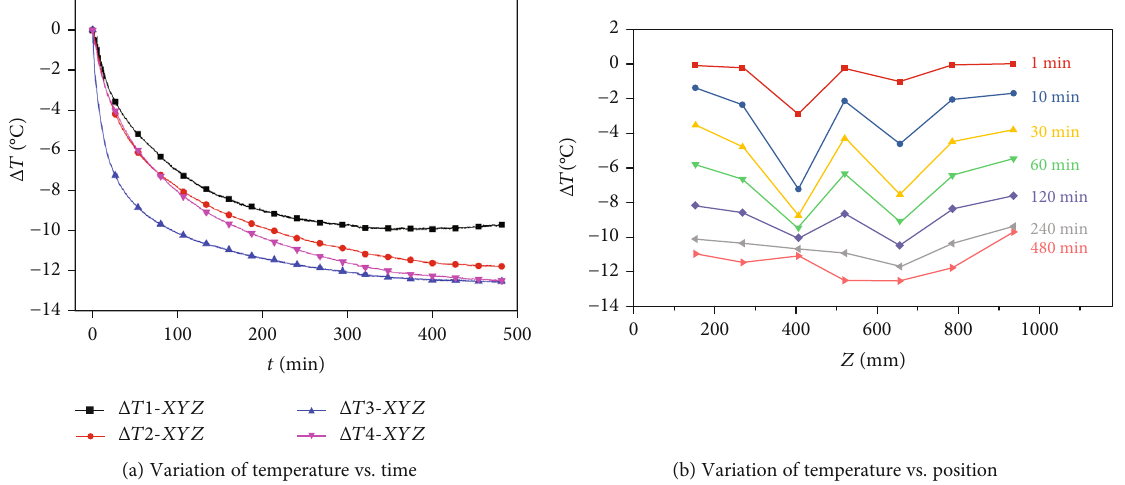
Figure 4: Evolution of coal temperature during gas